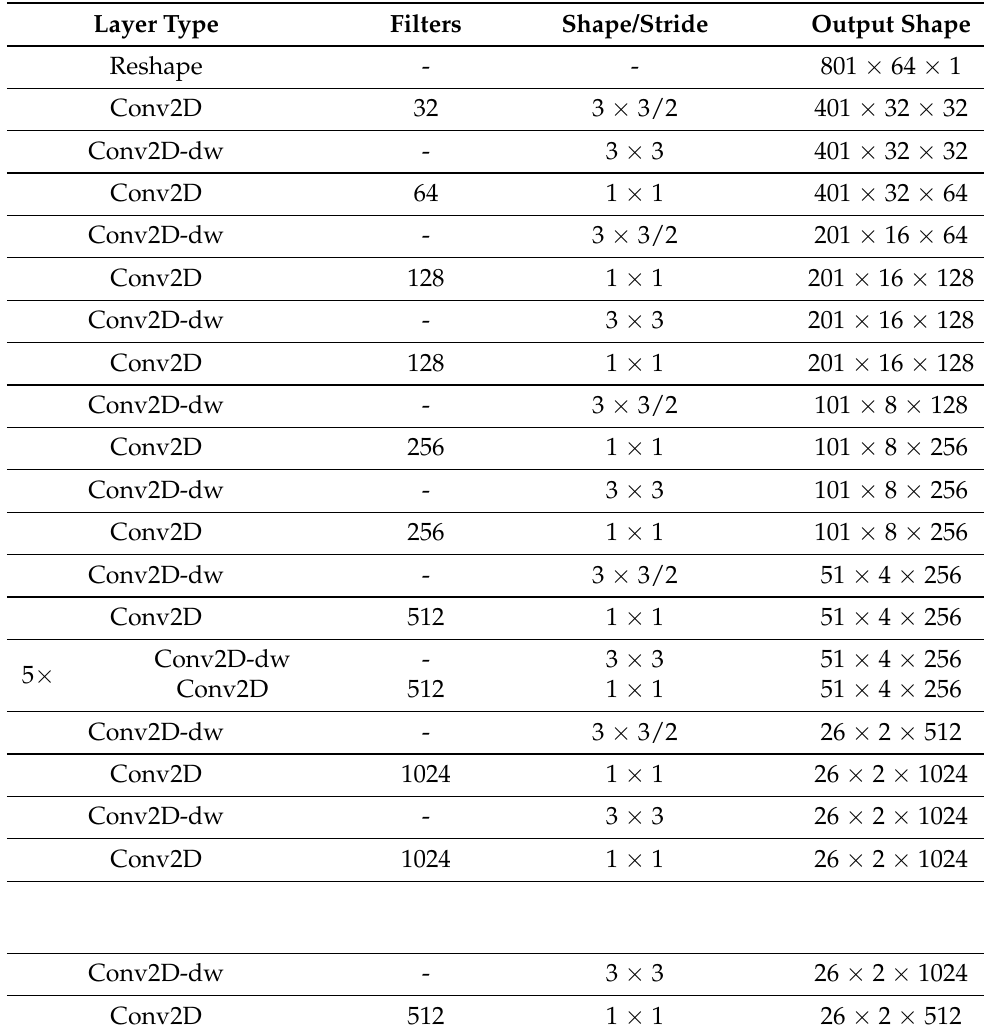
Table 1. The neural network architecture for YOHO. The upper half of the table comprises the original layers of MobileNet. The bottom half contains the layers that we have added. Conv2D and Conv1D stand for 2D and 1D convolutions, respectively. The convolutions use a stride of 1 unless mentioned otherwise and ‘dw’ stands for depthwise